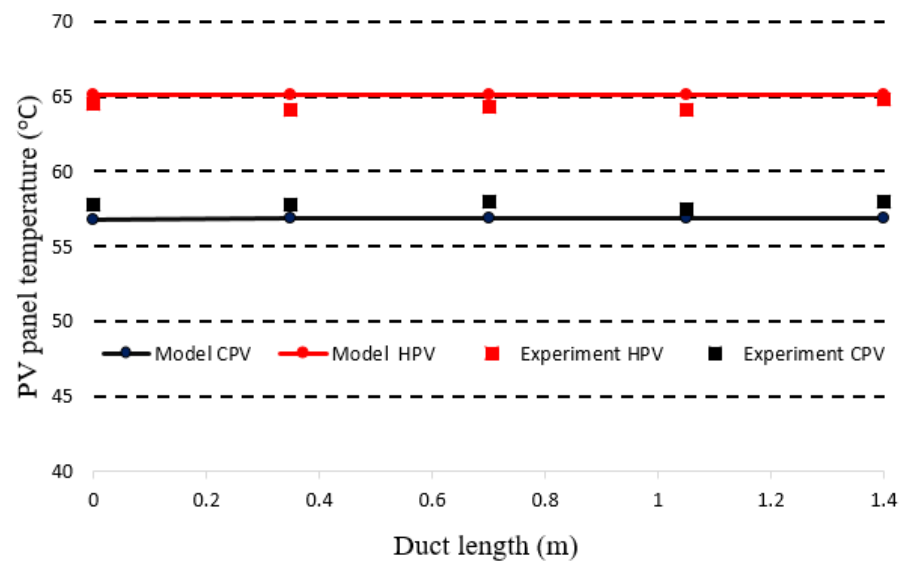
Figure 11. Experimental and simulated cooled and reference PV temperatures on 20 June at 14:05 (G = 797.88 W/m 2 , T am = 42.25 °C, temperature ( T ai ) = 43.72 °C, inlet water temperature ( T li ) = 25 °C, wind speed (WS) = 1.2 m/s, RH = 7.99%, 𝑚 𝑙𝑖 ̇ = 0.002 kg/s, 𝑚 𝑎𝑖 ̇ = 0.0166 kg/s).